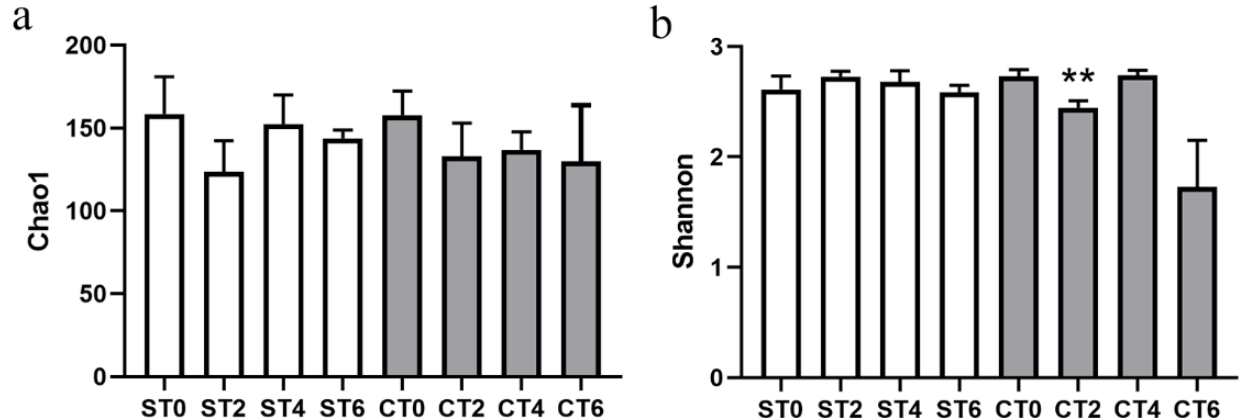
Figure 1. Histogram analysis of the alpha diversity of the intestinal microbiota. ( a ) Chao1 index bar chart; ( b ) Shannon index bar chart (ST—aqueous extract group; CT—alcohol extract group; 0—no chart; ( b ) Shannon index bar chart (ST — aqueous extract group; CT — alcohol extract group; 0 — no sample added; 2, 4, 6—denote fermentation days after sample addition; ** p < 0.01, with no sample sample added; 2, 4, 6 — denote fermentation days after sample addition; ** p < 0.01, with no sample added as the added as the control).